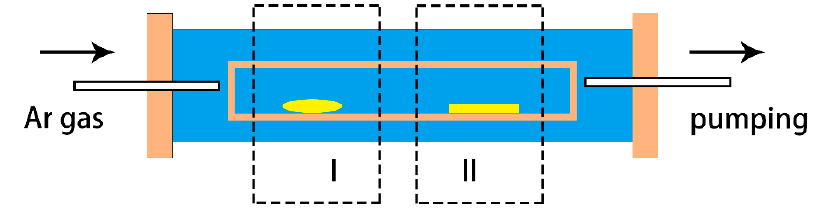
Figure 1. A diagrammatic sketch of the dual-zone tubular furnace.